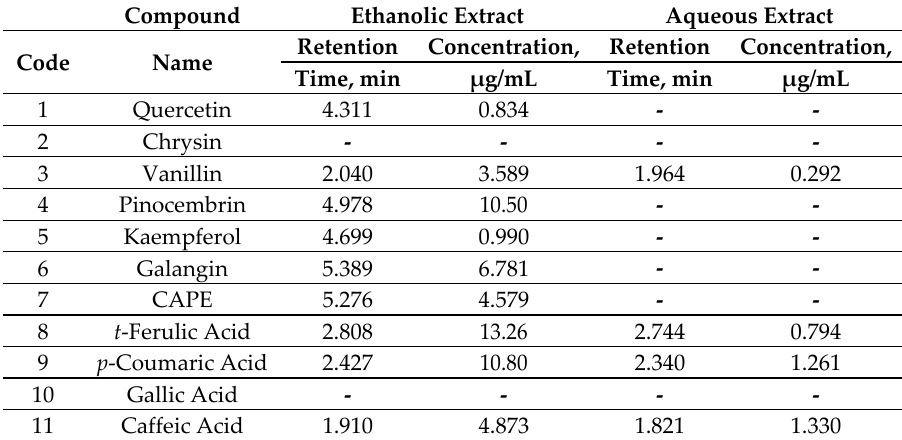
Table 5. Polyphenolics in ethanolic and aqueous